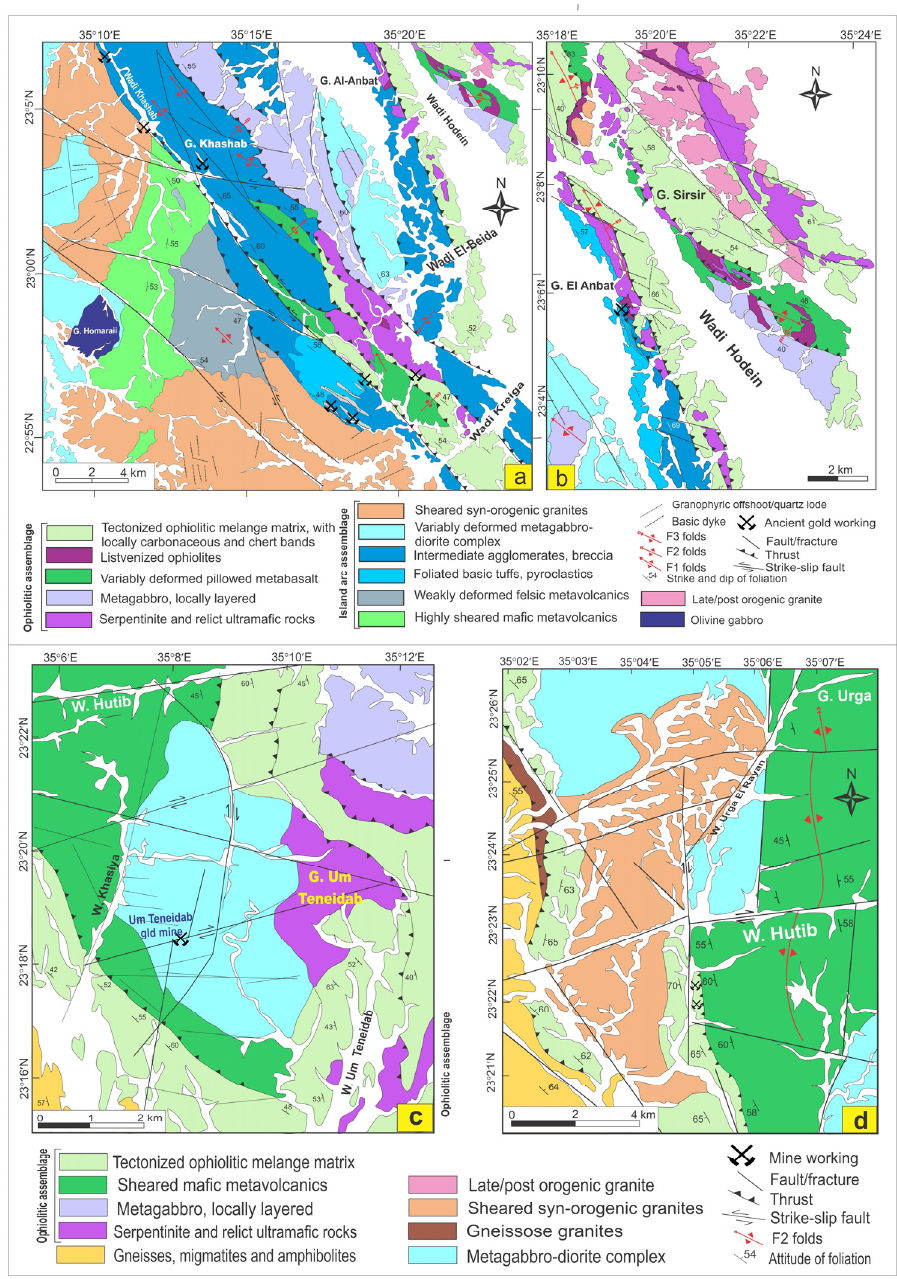
Figure 14. ( a ) Geological map of the Wadi El Beida–Wadi Khashab area (modified from Zoheir [39]); ( b ) geological map of Gabal El-Anbat–Wadi Hodein area (modified from [38]); ( c ) geological map of Um Teneidab area (modified from Hamimi and Sakran, [81]); and ( d ) geological map of Wadi Urga El Rayan area (modified from El Baraga, [48]).